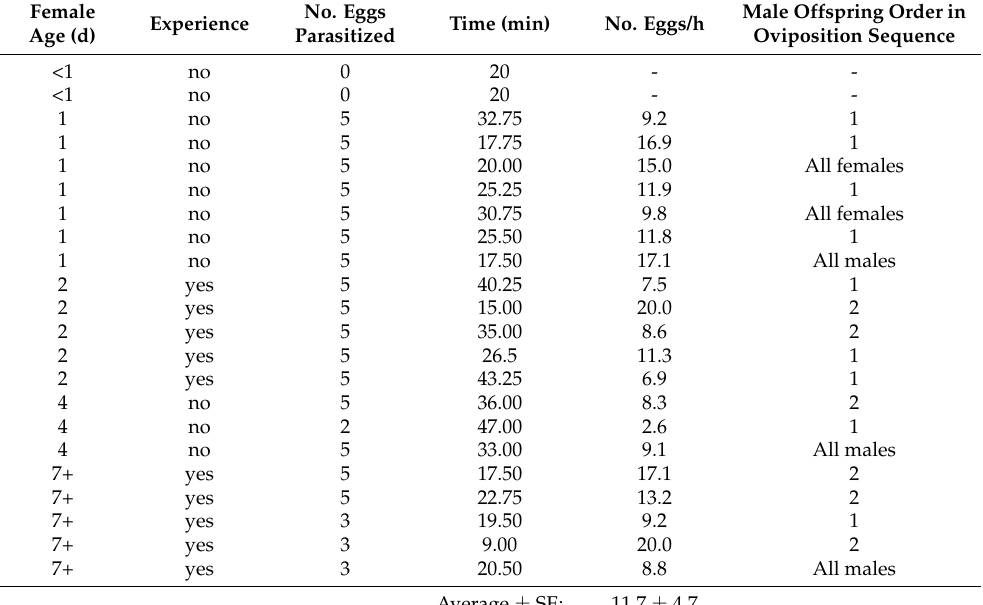
Table 1. Number of eggs parasitized, time spent parasitizing, and position of the first male egg in the oviposition sequence of naïve and experienced G. aetherium females of different ages. Female Age